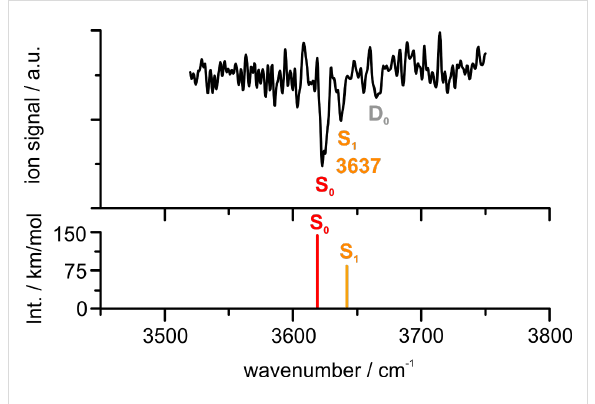
Figure 6: UV/IR/UV spectrum of PVE–MeOH in the range of 3520–3750 cm − 1 ; excitation laser: 36741 cm − 1 , ionizing laser: 31847 cm − 1 , carrier gas helium; the lower trace shows the calculated OH stretching frequencies at the SCS-CC2/def2-TZVP level for the op- timized S 0 and S 1 structure of the OH–O’ isomer scaled by